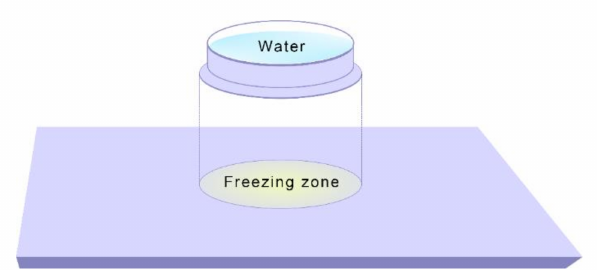
Figure 3. Experimental set up for freeze/thaw test. Water contained in the plastic cylinder was allowed to ice in contact with the surfaces.